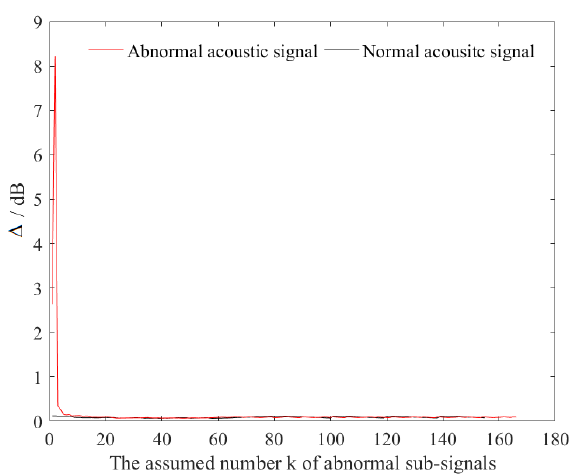
Figure 8. SNR increment sequence ∆ .